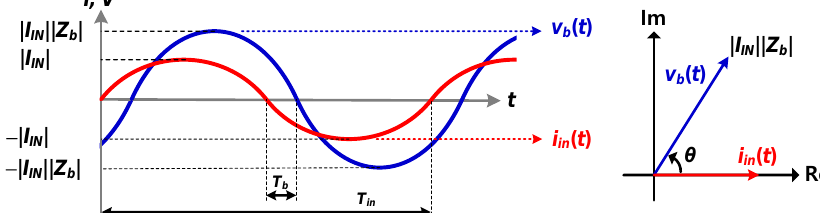
Figure 1. Magnitude and phase of the resulting voltage determined by the impedance under measurement.